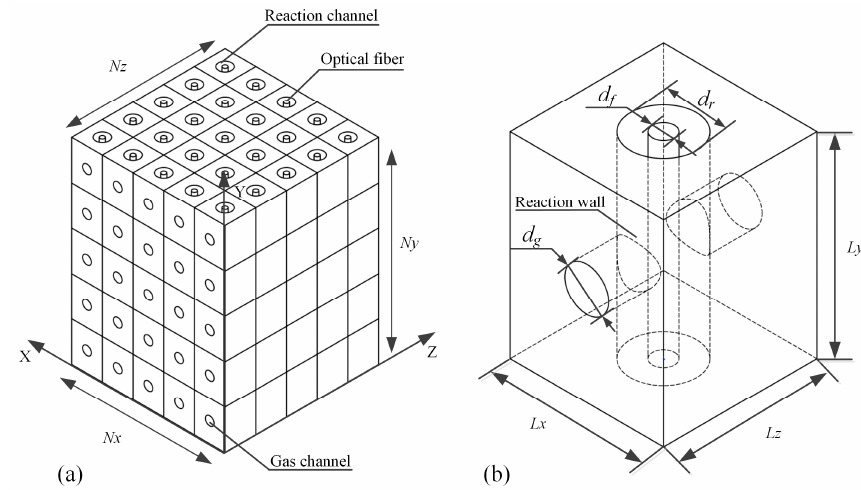
Figure 3. Diagram of transmission process of rays.